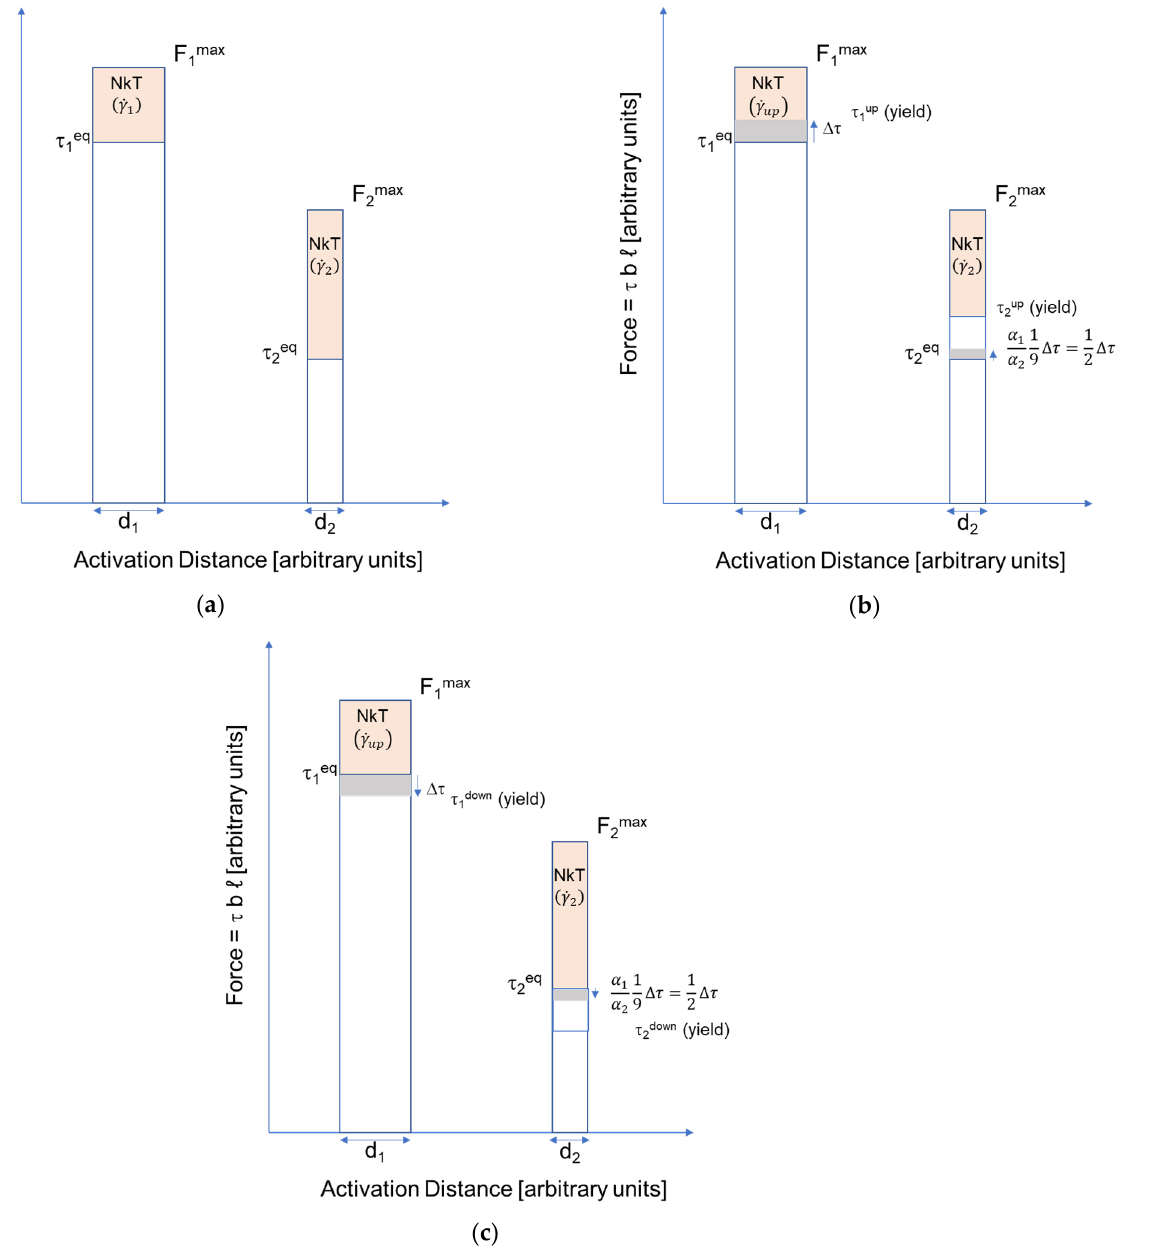
Figure A1. ( a ) Kinematic representation of force-distance energy diagram at flow stress τ eq. ( b ) Same as ( a ) with increase of flow stress by ∆ τ . ( c ) Same as ( a ) with decrease of flow stress by ∆ τ . In Figure A1(b), the ∆ τ increase on type 1 decreases the available thermal energy that in turn increases the probability of activation to accommodate the increase in strain